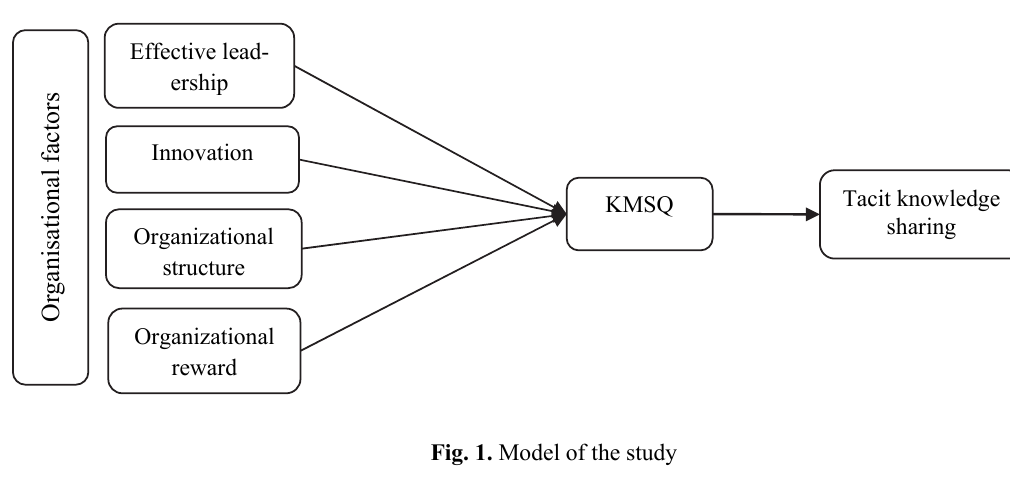
Fig. 1. Model of the